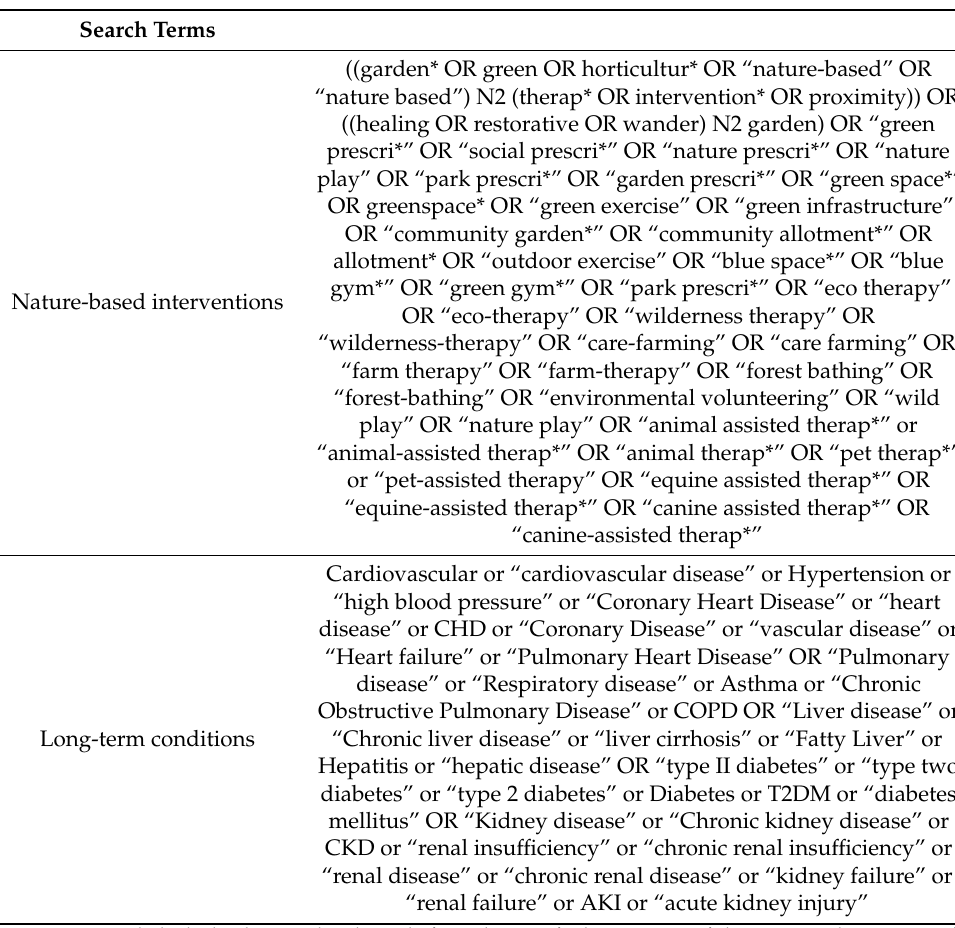
Table 2. Free text search terms for nature- and animal-based interventions with long-term conditions. These were combined with the Boolean operator